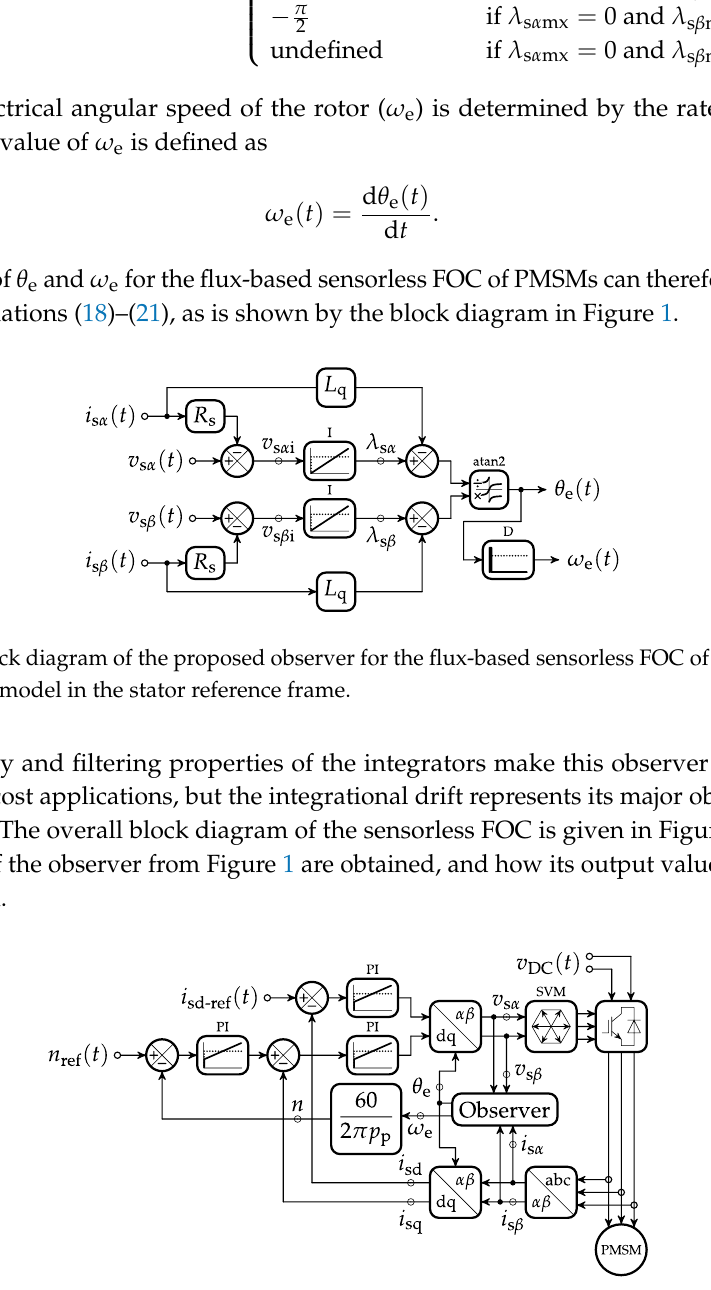
Figure 2. A block diagram of the sensorless FOC of